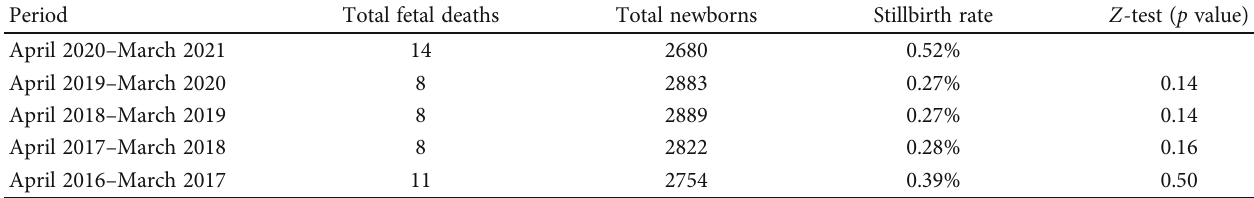
Table 2: Five-year analysis of stillbirth rate in a tertiary centre in